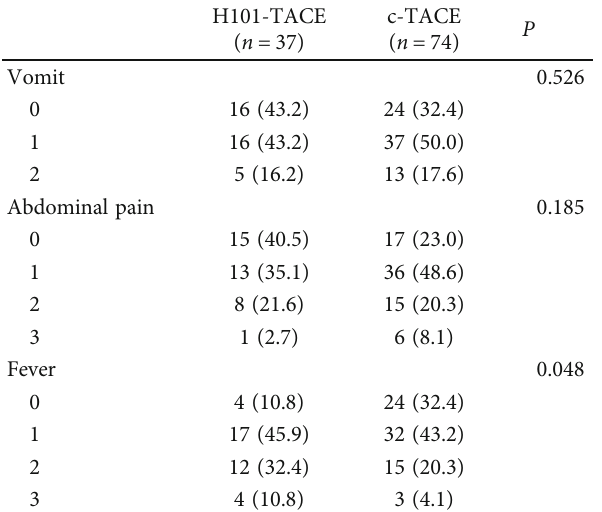
Table 6: Incidence of postoperative adverse reactions in two